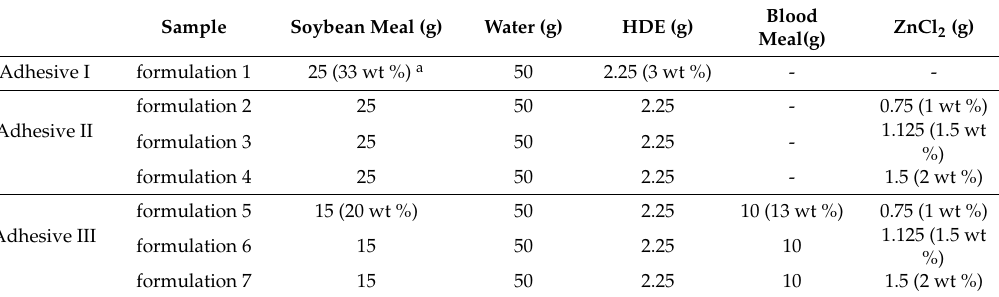
Table 1. Formulations of the